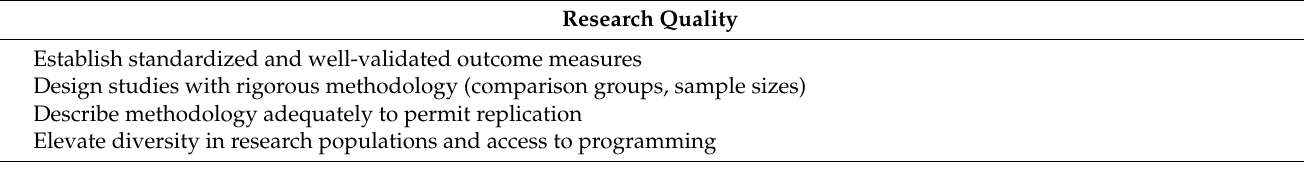
Table 2. Recommendations for HAI research advancement generated by participants at the Summit on Social Isolation and Companion Animals held in Washington, DC, in May